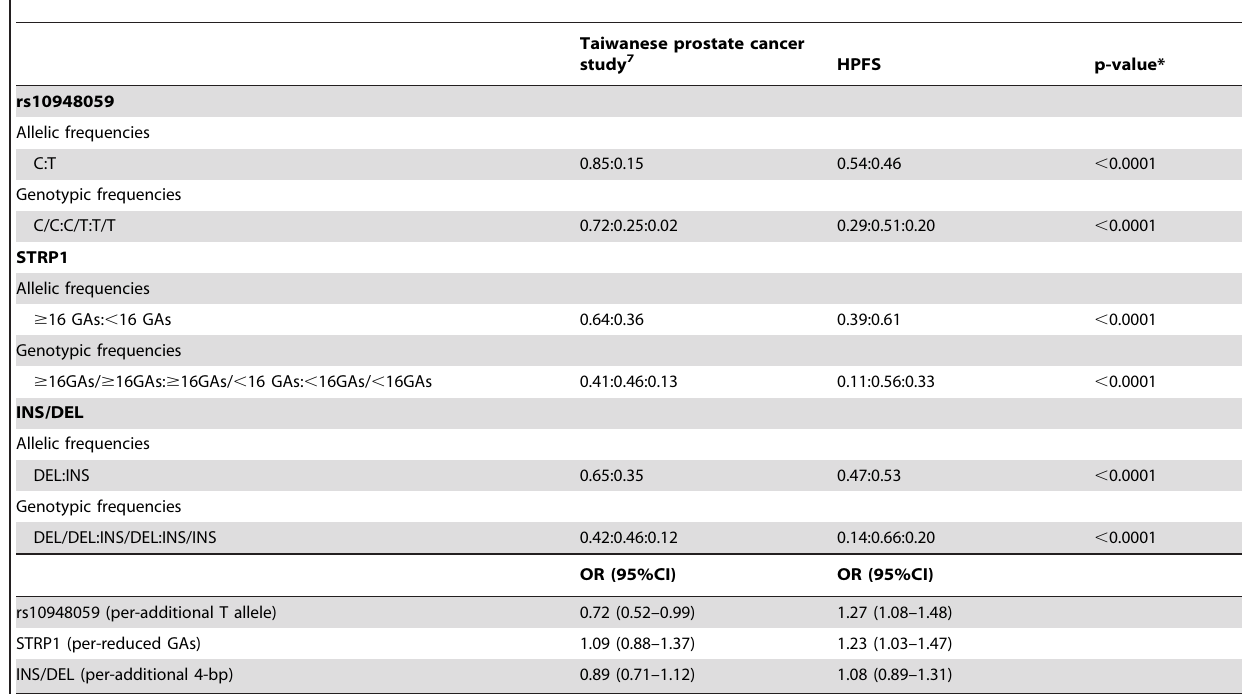
Table 5. Frequency of the polymorphisms and association of the risk alleles with prostate cancer in Taiwanese prostate cancer study and HPFS